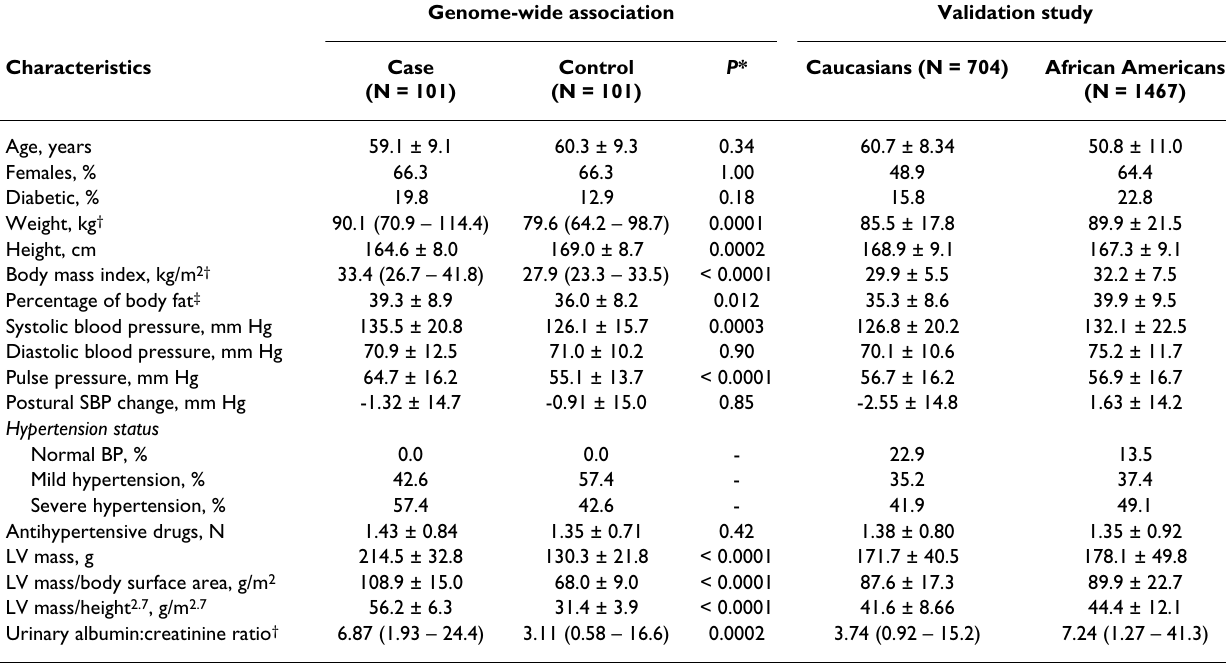
Table 1: Demographic and clinical characteristics by case-control status and validation study population.